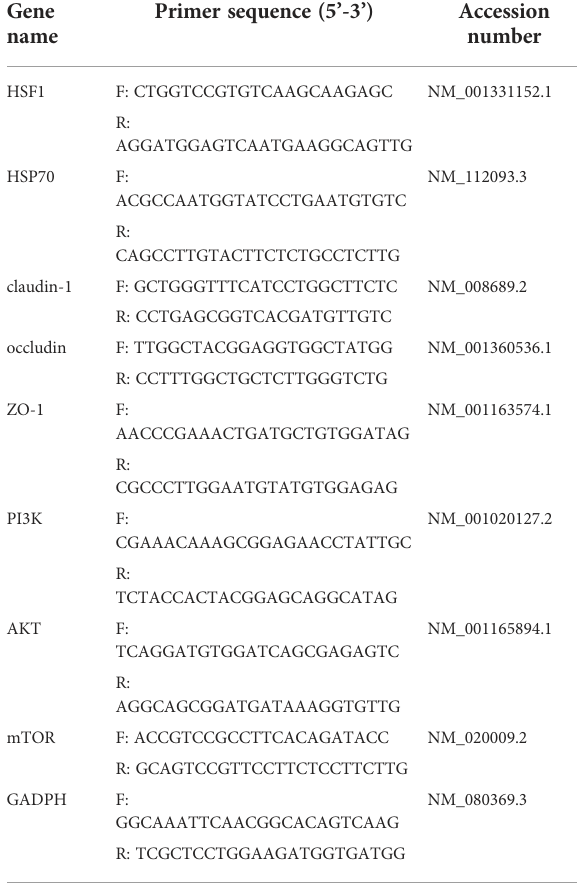
TABLE 2 Primer sequences for